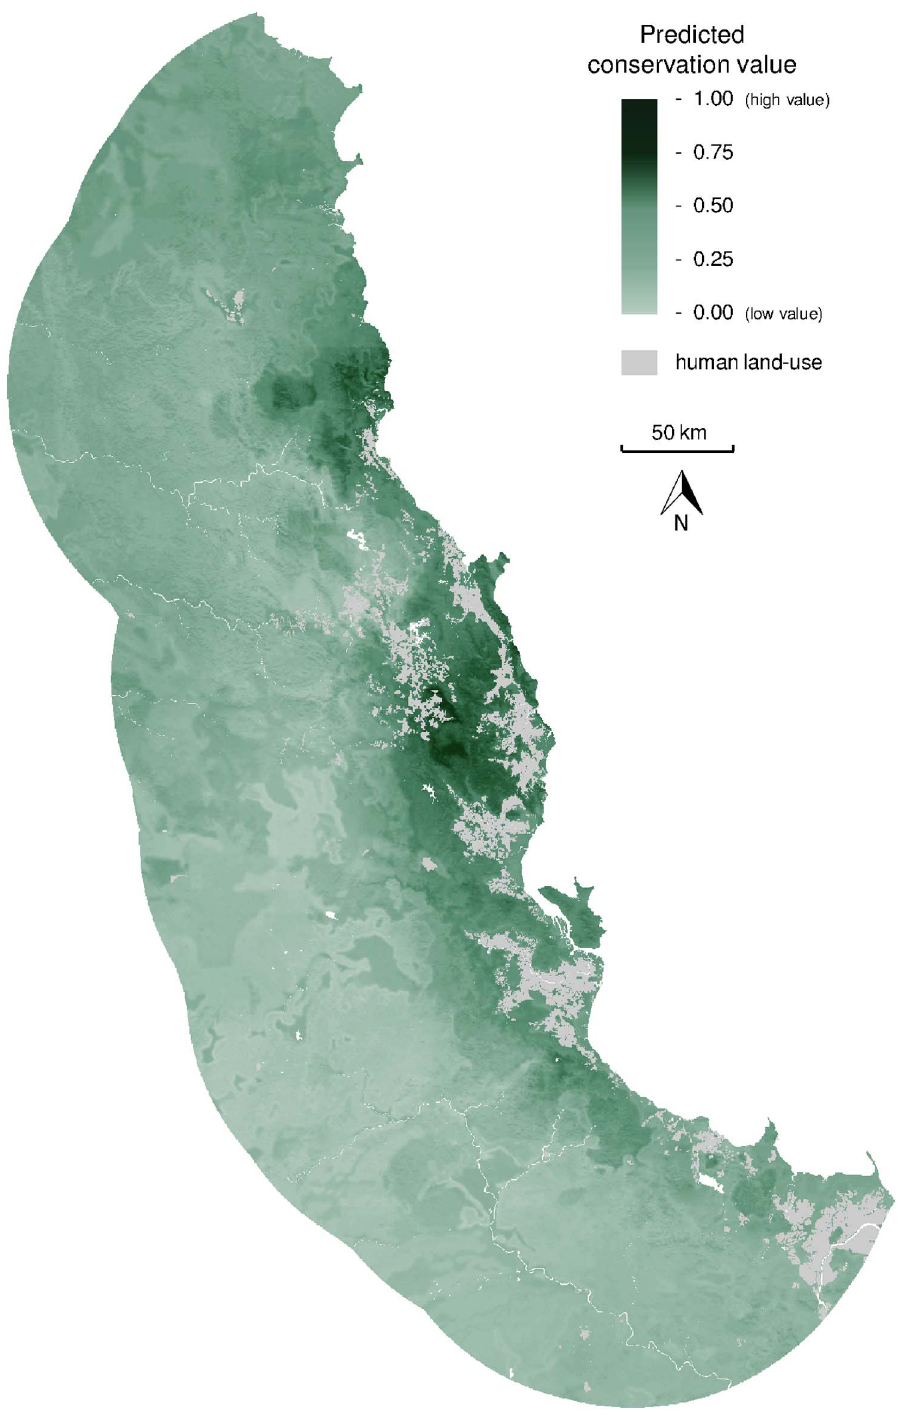
Figure 5. Predicted conservation value. Predictions of the overall conservation value for plant diversity of each community (grid cell) in the Australian Wet Tropics, as synthesised across the four different elements of diversity we considered (from Fig. 3).